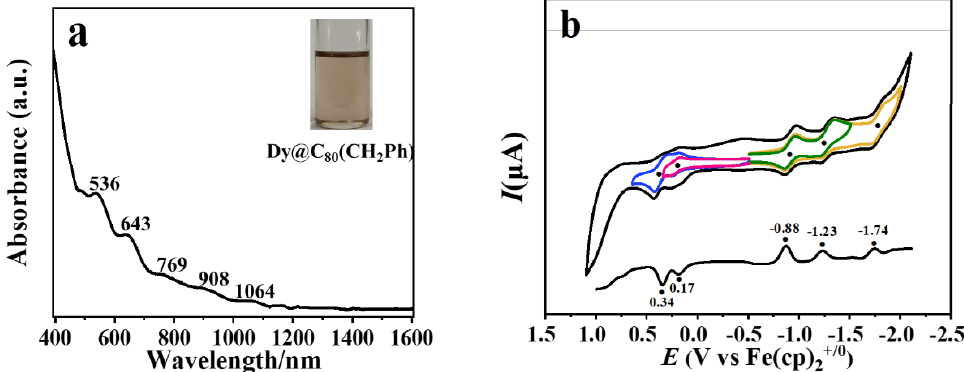
Figure 4. ( a ) UV-Vis-NIR absorption spectrum of Dy@ C 2v (5)-C 80 (CH 2 Ph). ( b ) Cyclic voltammograms of Dy@ C 2v (5)-C 80 (CH 2 Ph) in o-DCB solution with ferrocene (Fc) as the standard under different scan regions. Scan rate: 100 mV/s, TBAPF 6 as supporting electrolyte. The half-wave potentials (E 1/2 ) of each redox step are marked with a solid dot to aid comparison.